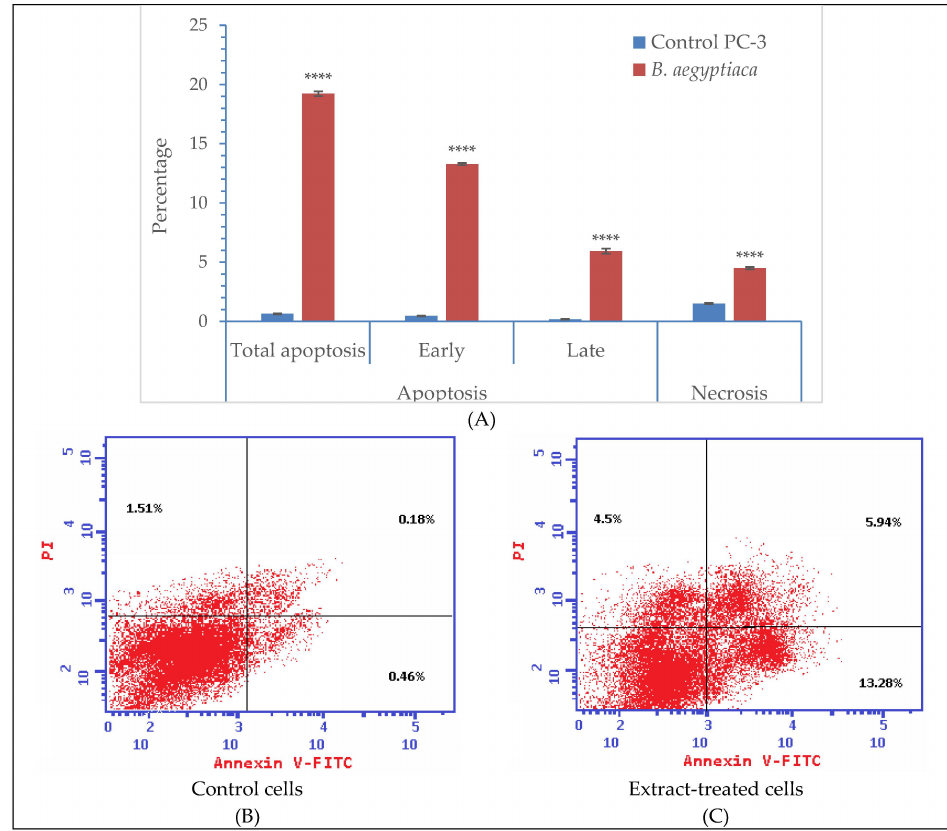
Figure 8. Apoptotic effect of B. aegyptiaca methanolic fruit extract at 92 µ g/mL on PC-3 cells: ( A ) Pro- portions of the total, early and late apoptotic cells vs necrotic cells for non-treated and treated PC-3 cells. Statistical differences are indicated by **** at p < 0.0001 assessed by independent t -test. The data were generated from 3 replicates and presented as means ± SD denoted by the vertical bars. ( B ) flow cytometry dot plots of control cells; ( C ) flow cytometry dot plots of extract-treated cells showing necrotic cells (upper left quadrant), late apoptotic cells (upper right quadrant), viable cells (lower left quadrant), and early apoptotic cells (lower right quadrant).